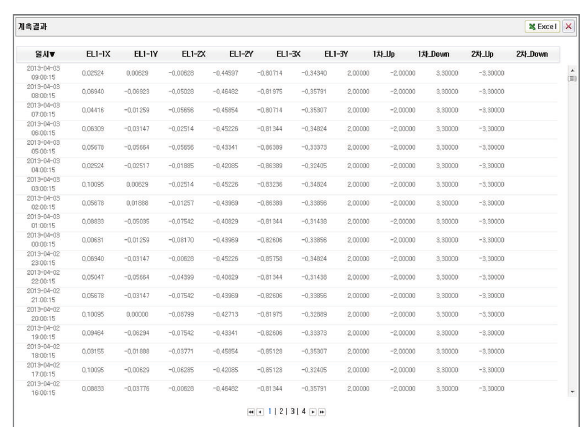
Figure 10: Saving function and saved result lists through MS